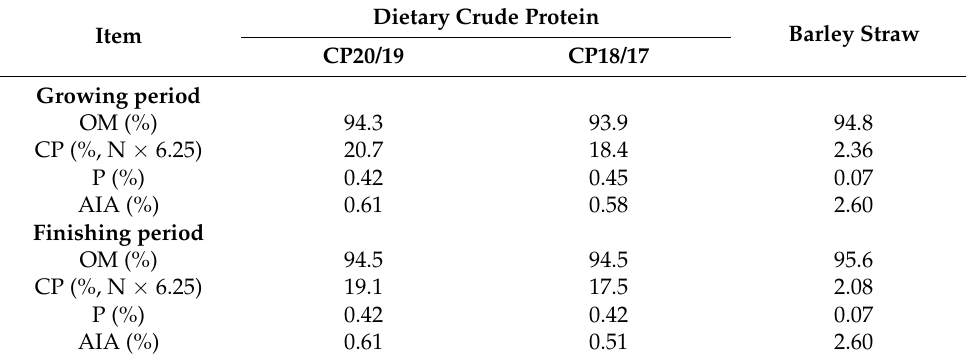
Table 1. Dietary composition in the growing and finishing